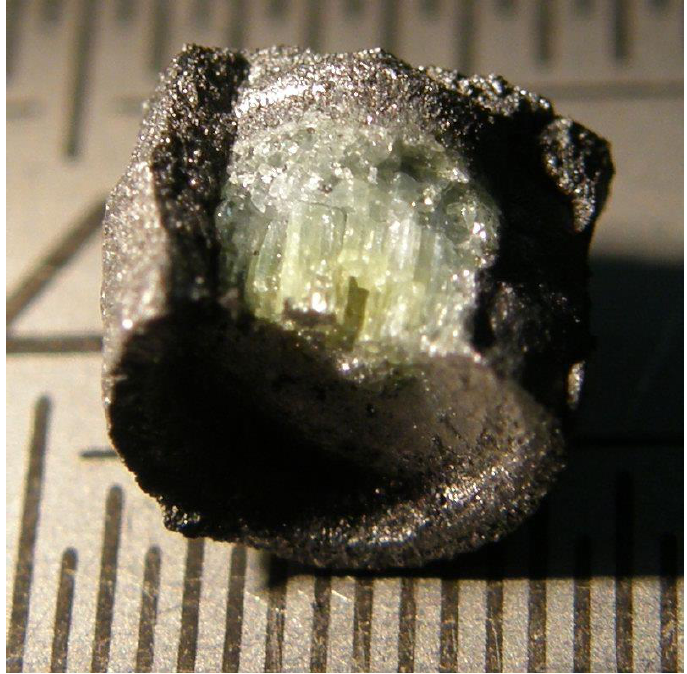
Figure 6. Microphotograph of zinc oxide single crystals grown from melt at high pressure (in the opened graphite heater after extraction from the high-pressure cell; scale value is 0.5 mm).